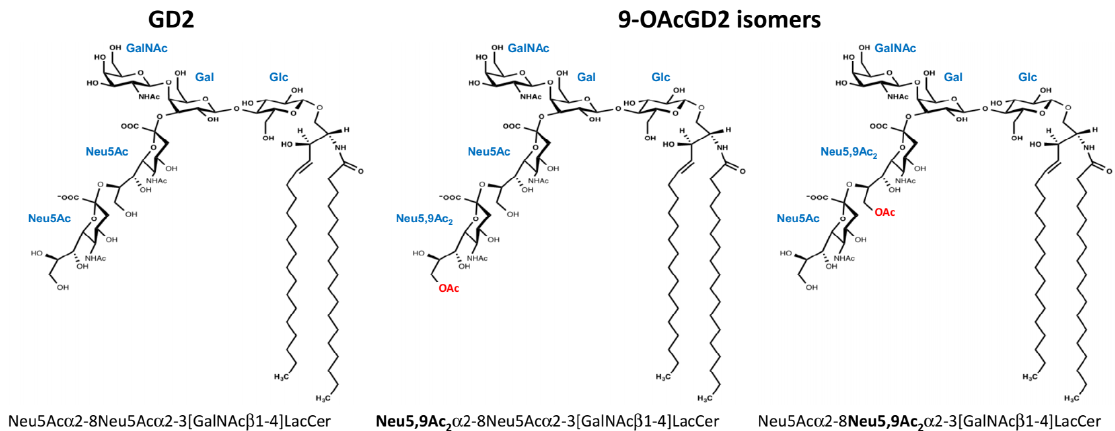
Figure 1. Structure of GD2 and O AcGD2 isomers identified in BC cells, with a 9- O -acetyl group (in red) either on the terminal or the subterminal sialic acid residue, resulting in Neu5,9Ac 2 α 2-8Neu5Ac α 2-3[GalNAc β 1-4]LacCer or Neu5Ac α 2- 8Neu5,9Ac 2 α 2-3[GalNAc β 1-4]LacCer structures,